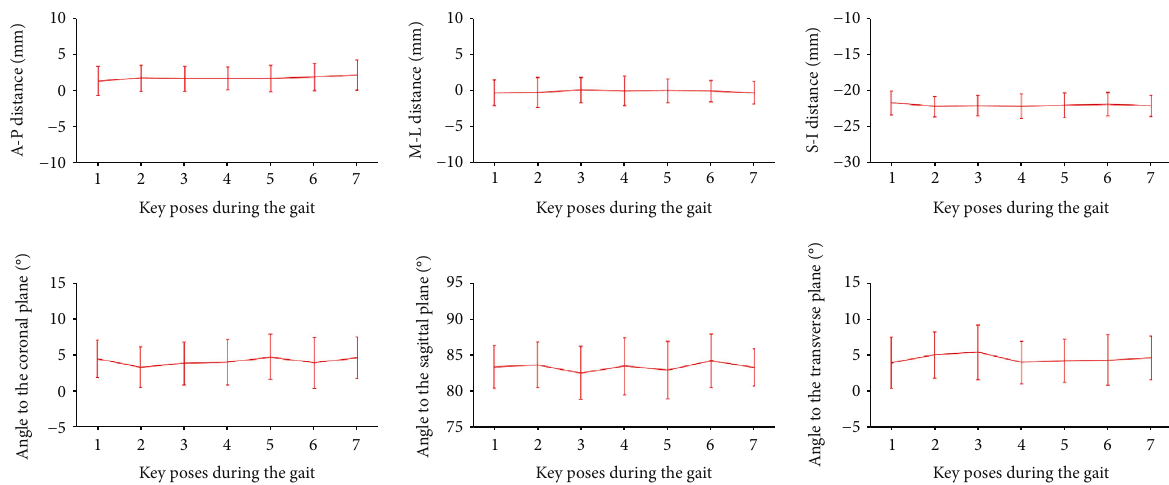
Figure 3: The position (A – P distance, M – L distance, S – I distance) and (Angle to the coronal, sagittal, and transverse plane) of the GATJ at seven key poses (A – P: Anterior – Posterior; M – L: Medial – Lateral; S – I: Superior – Inferior).